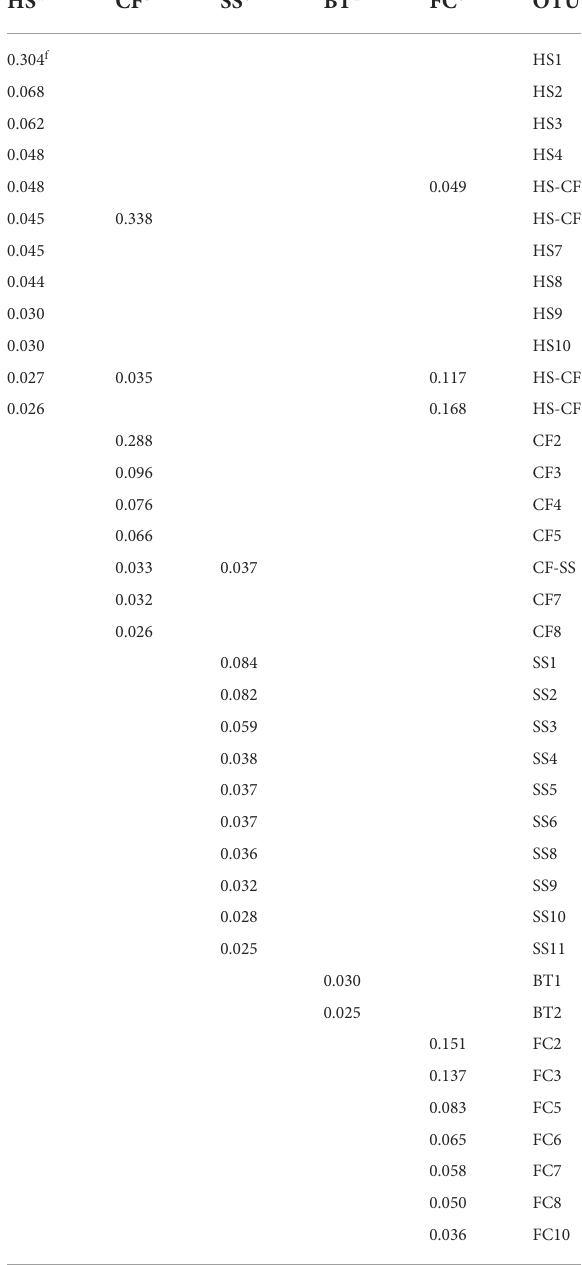
TABLE 1 Species of Bacteroidetes identified in the